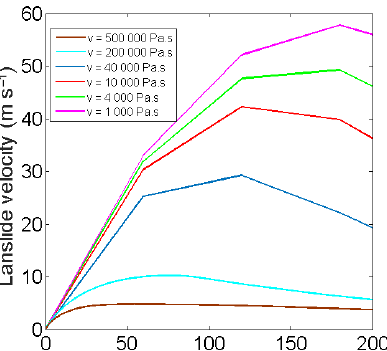
Figure 6. Landslide velocity as a function of time for the dynamic viscosities v tested here.